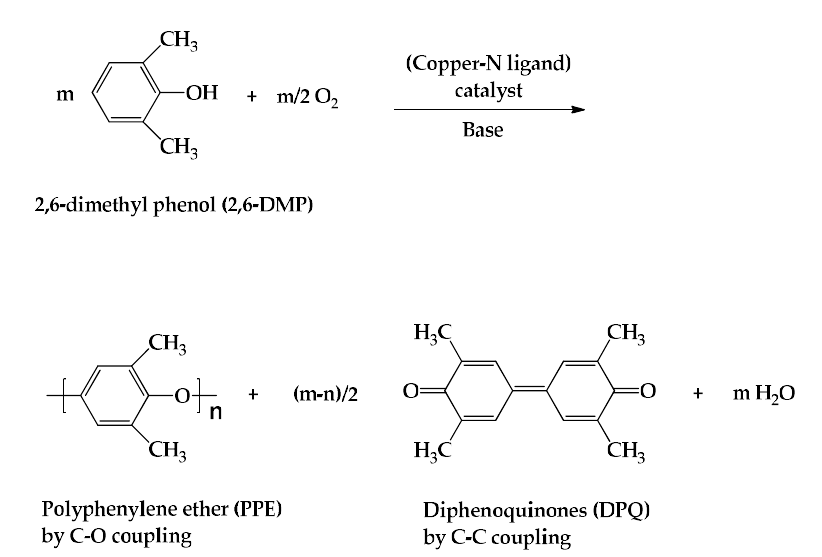
Figure 1. Synthesis of poly(2,6-dimethyl-1,4-phenylene ether) (PPE) by the copper-catalyzed oxidative coupling of dimethylphenol (2,6-DMP).